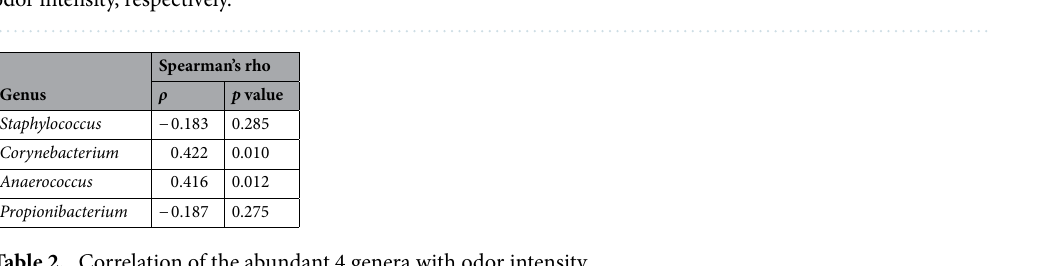
Table 2. Correlation of the abundant 4 genera with odor